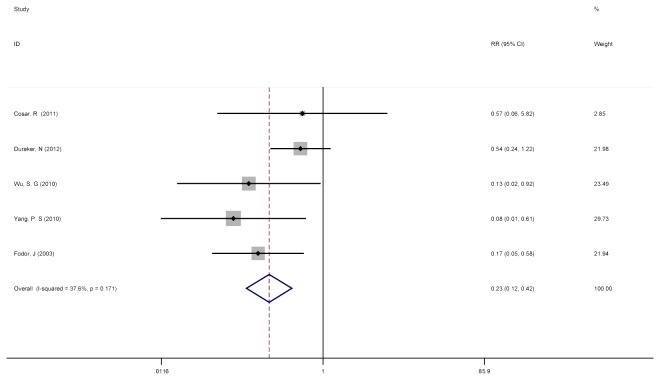
No PMRT versus PMRT after mastectomy surgery for the T2, N1-3+ subgroup on LRR.Five studies with detailed information were involved to investigate the role of PMRT in T2/N1-3+ patients. The pooled RR for LRR in patients with PMRT was 0.226 (95% CI = 0.121 to 0.424), and significant heterogeneity (Cochran’s p = 0.171; I2 = 37.6%) was not detected between the 5 studies included in this portion of the meta-analysis [11,12,17,19,23].